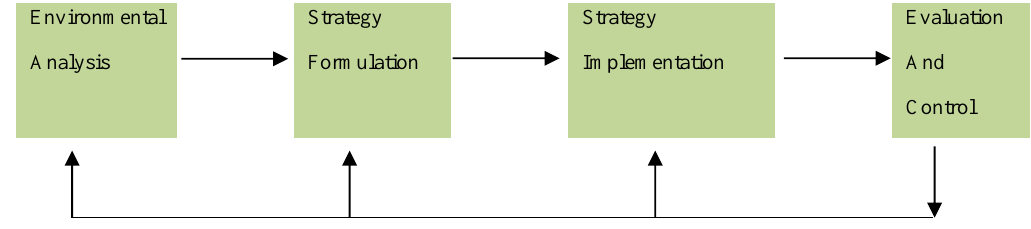
Figure 1: Basic Model of Strategic